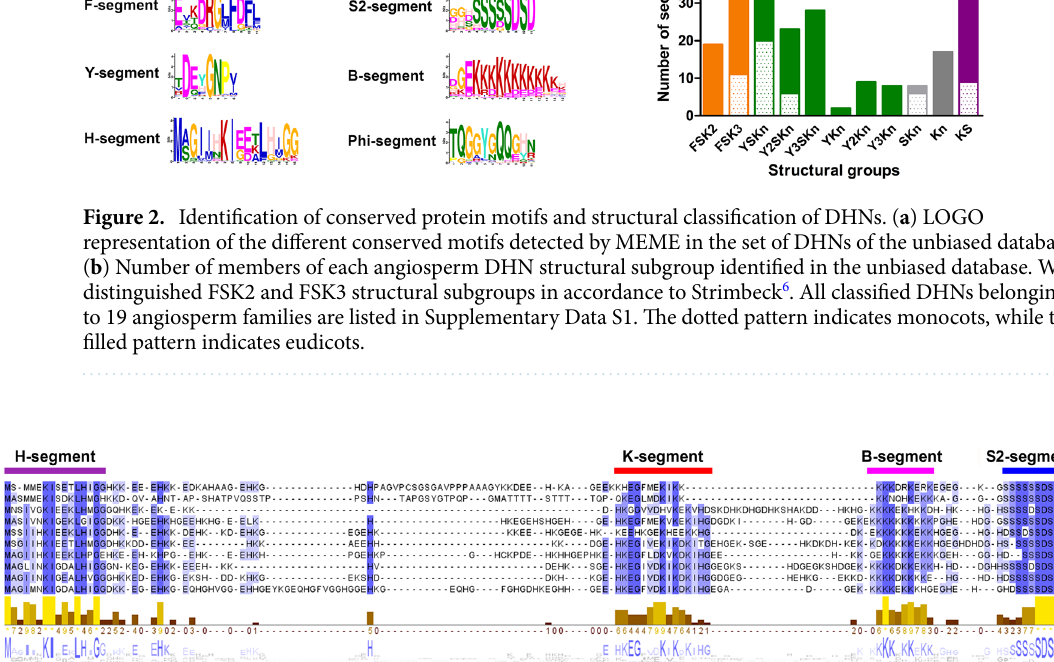
Figure 3. Conservation of KS-DHNs in vascular plants. Multiple sequence alignment of KS-DHNs (HKS- DHNs) of representative angiosperms ( A. trichopoda , S. bicolor , N. nucifera , A. thaliana , M. truncatula ) and non-angiosperms (the lycophyte S. moellendorffii and the gymnosperm G. biloba ) performed with T-Coffee and visualised with Jalview. The H-, K-, B and S-segments are indicated. Note that the general structure of the proteins is conserved in all vascular plant